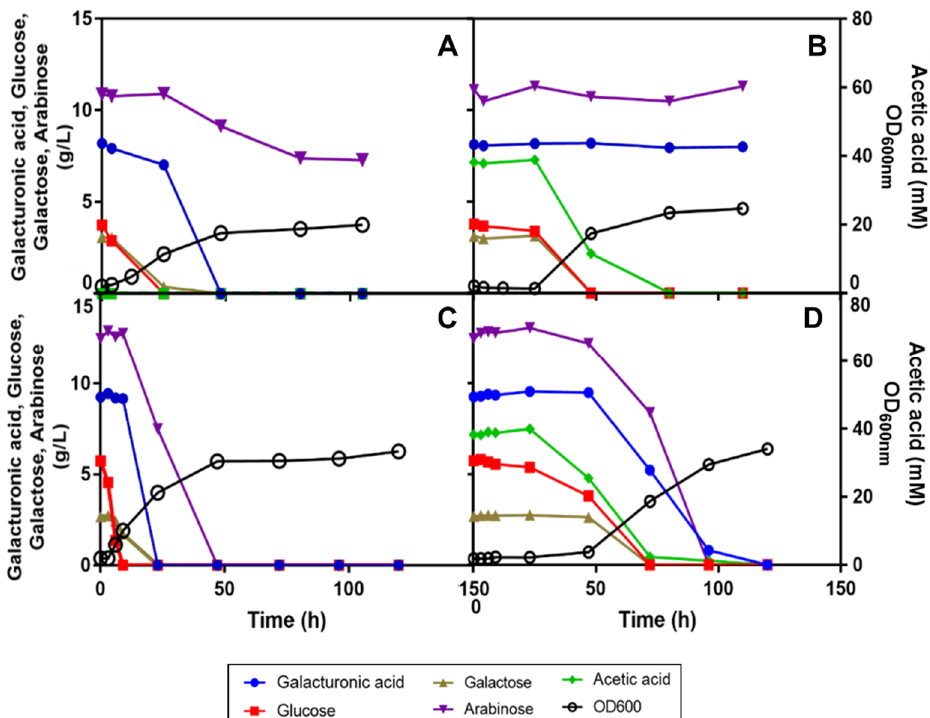
Figure 3. Effect of acetic acid and/or amino acid supplementation of synthetic SPB hydrolysate on the catabolism of different carbon sources by R. toruloides PYCC 5615. Growth and carbon sources’ utilization profiles by R. toruloides PYCC 5615 when cultivated in: ( A ) mixed-sugar medium (9 g/L D -galacturonic acid, 4 g/L D -glucose, 3 g/L D -galactose, 12 g/L L -arabinose) prepared in Yeast Nitrogen Base (YNB) (with 5 g/L ammonium sulphate), ( B ) the same mixed-sugar medium as in ( A ) supplemented with 40 mM of acetic acid, ( C ) the same mixed-sugar medium as in ( A ) supplemented with amino acids (10 mg/L of L -histidine, 20 mg/L of DL -methionine and 20 mg/L DL -tryptophan) and ( D ) the same mixed-sugar medium supplemented with amino acids as in ( C ) and with 40 mM of acetic acid. Media were adjusted at pH 5.0, cultures were inoculated with an initial OD 600 nm of 2 and cultivation was carried out at 30 °C with orbital agitation (250 rpm).